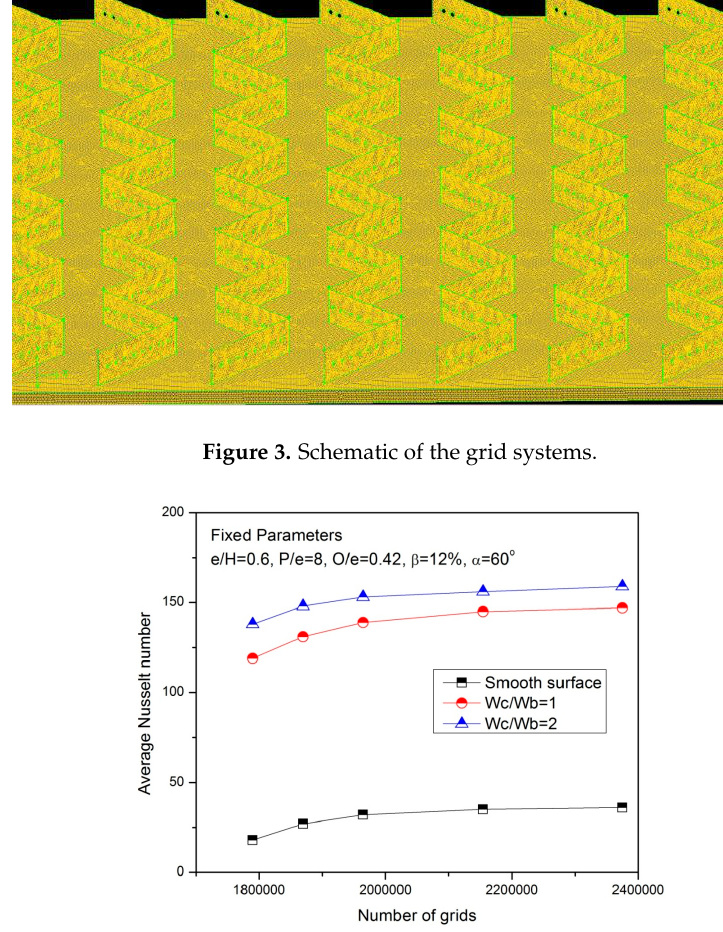
Figure 4. Variation in average Nusselt number with respect to the number of grids for a width ratio ( Wc / Wb = 1.2) and a smooth surface rectangular channel with the Reynolds number of 7000.